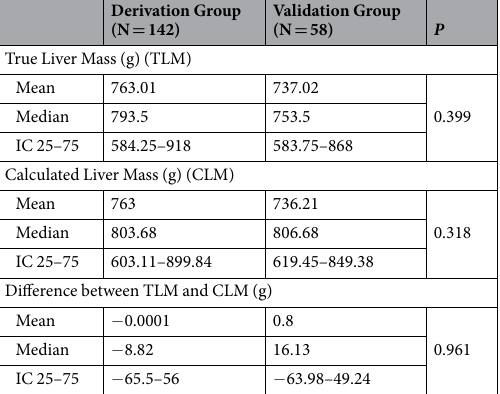
Table 2. True vs. Calculated liver mass. IQR, interquartile range.